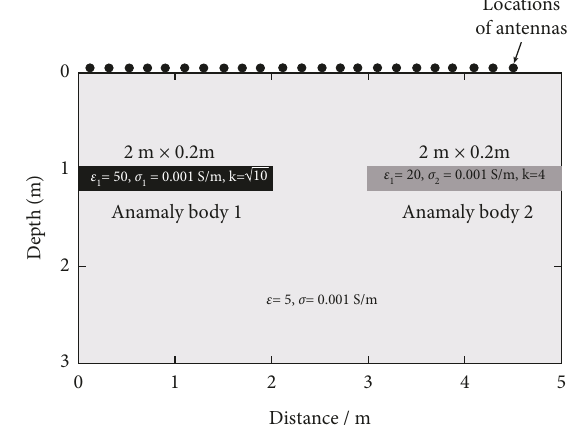
Figure 1: Diagram of the forward simulation model. The elec- tromagnetic wave transmits vertically into the interface, and the transmitting and receiving antennas are in the same place at each surveying point.